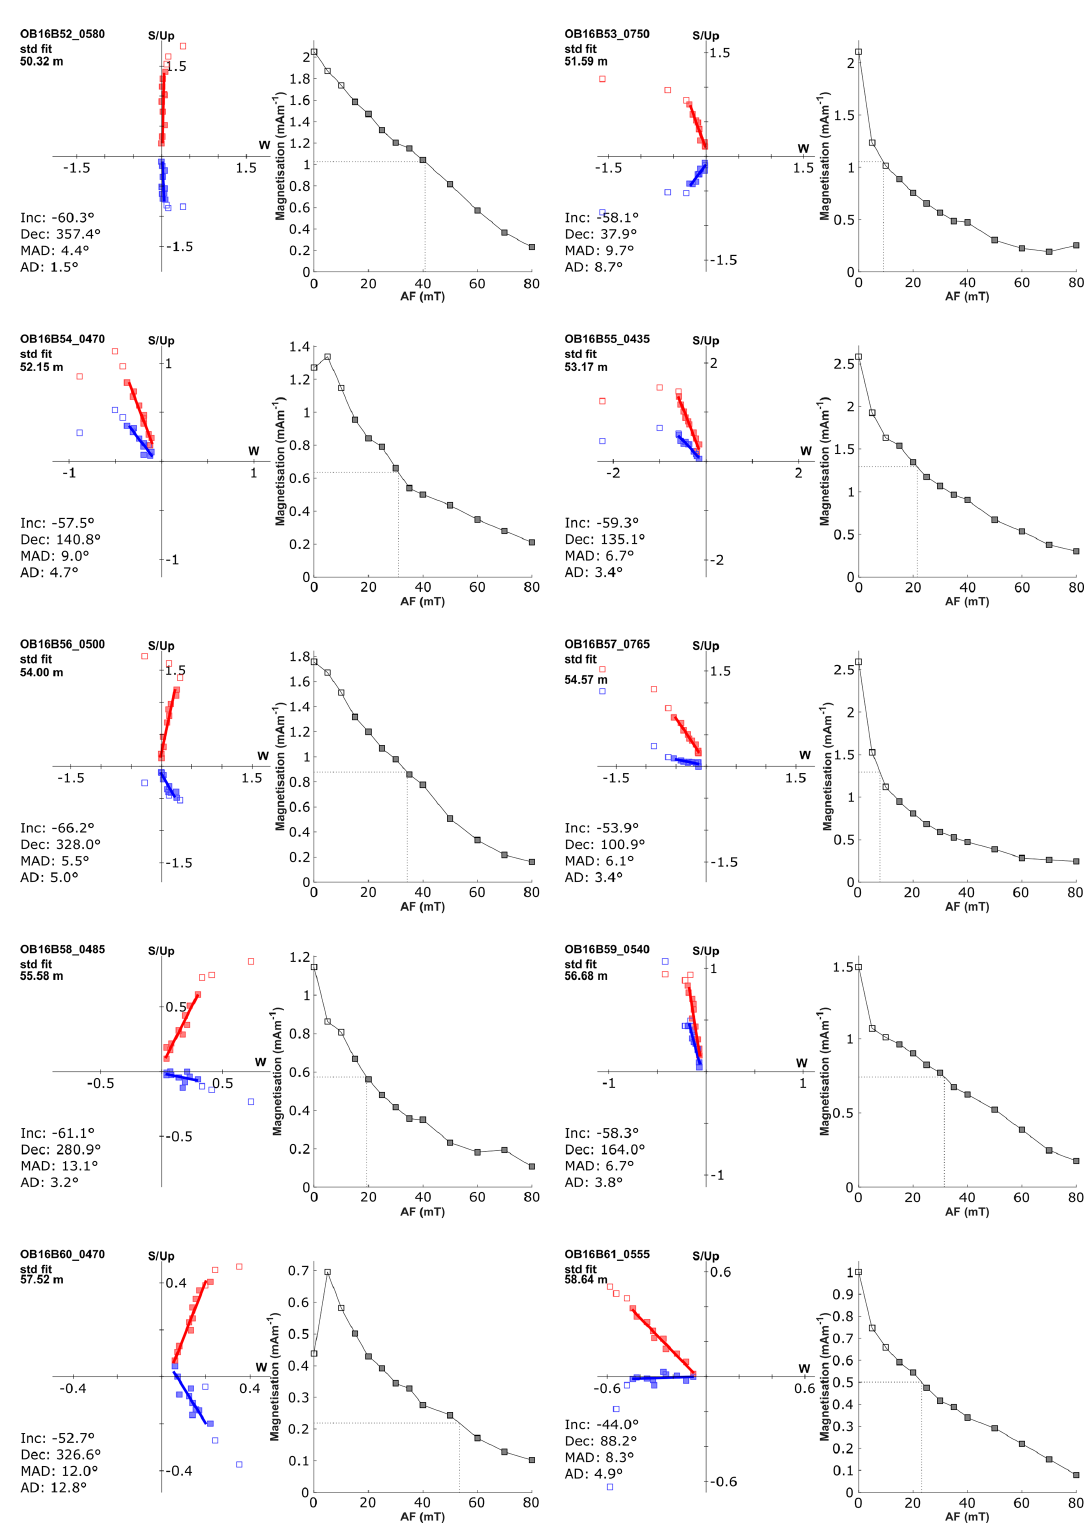
Figure C2. Orthogonal plots and intensity of magnetisation after stepwise demagnetisation of pilot samples